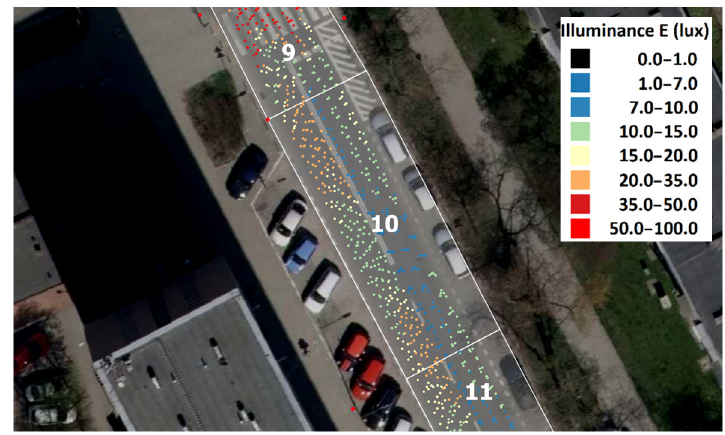
Figure A6. Example of five illuminance measurements in field No. 10.